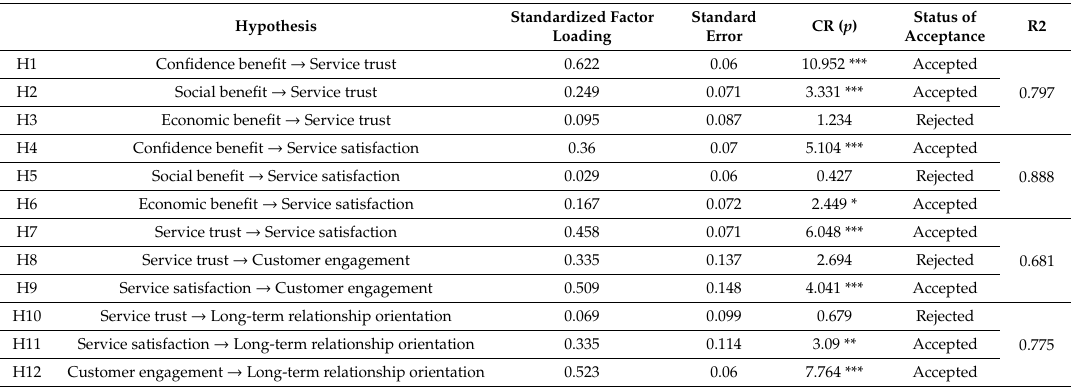
Table 5. Hypotheses verification.